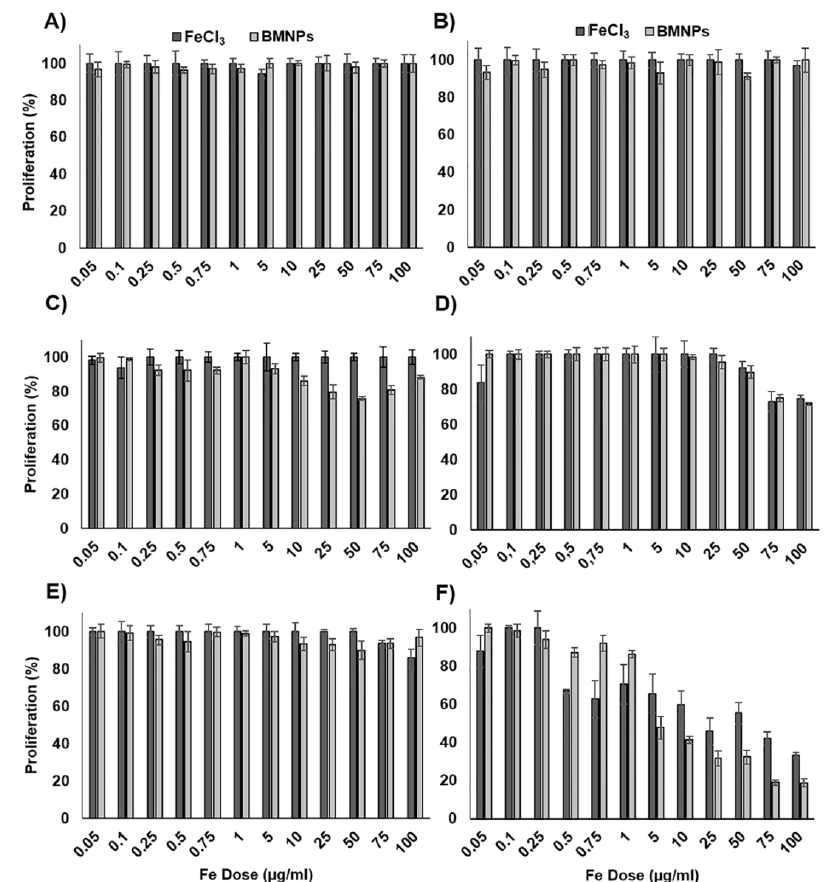
Figure 4. Cell proliferation assay of colon cell lines treated with BMNP and FeCl 3 . The cell lines HT29 ( A ), SW480 ( B ), HCT15 ( C ), MC38 ( D ), T84 ( E ), and CCD18 ( F ) were exposed to increasing concentrations of Fe from 0.05 to 100 µ g / mL from FeCl 3 and BMNPs for 72 h. The graphs represent the percentages of proliferation of all the cell lines obtained using the SRB assay. Data represent the mean values ± SD of triplicate